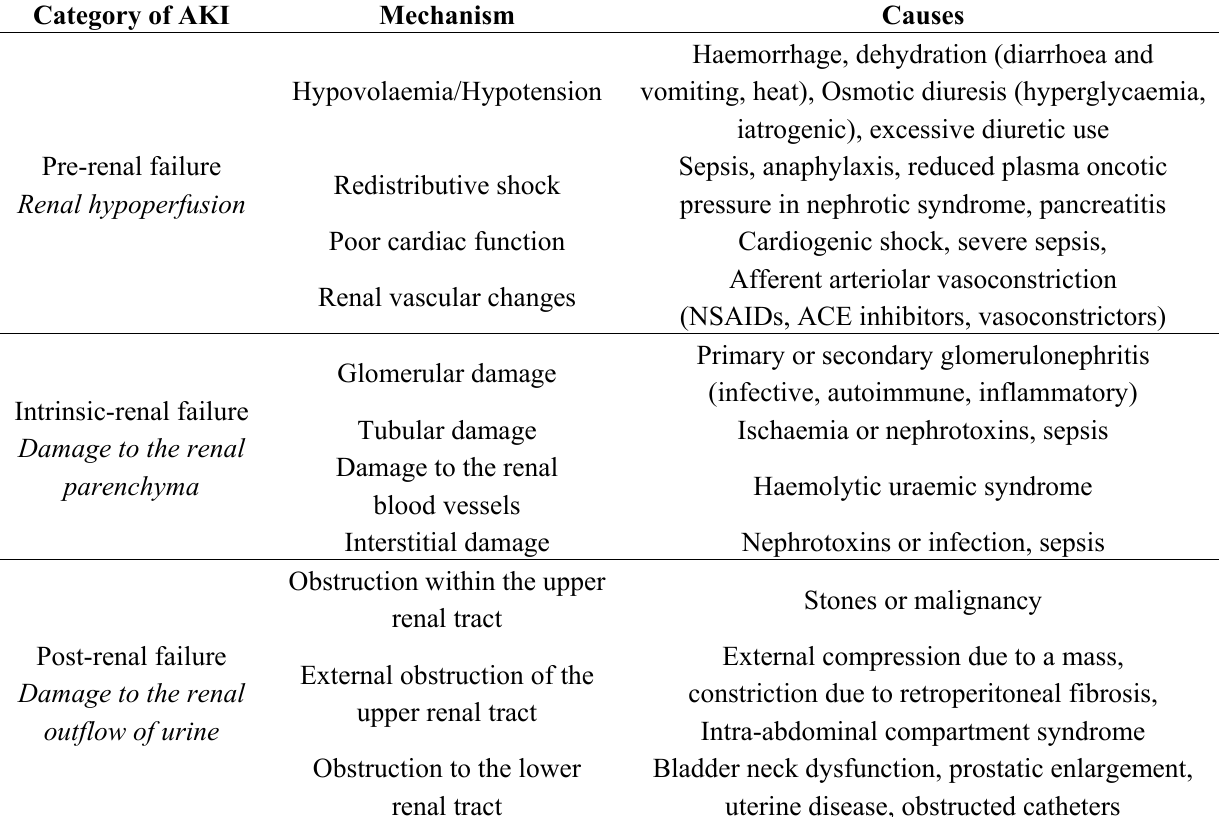
Table 1. Causes of acute kidney injury